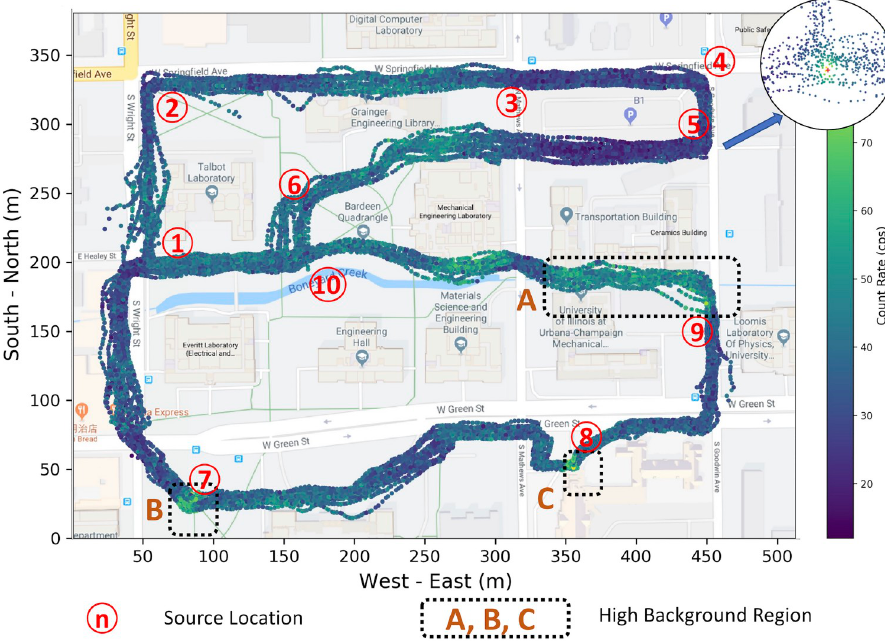
Fig 1. Illustration of experimental area, background radiation measurements, and radioactive source locations. Three relatively high background regions, namely the Nuclear Radiation Laboratory (A), the Alma Mater statue (B), and the Church (C) are denoted using dotted rectangles.